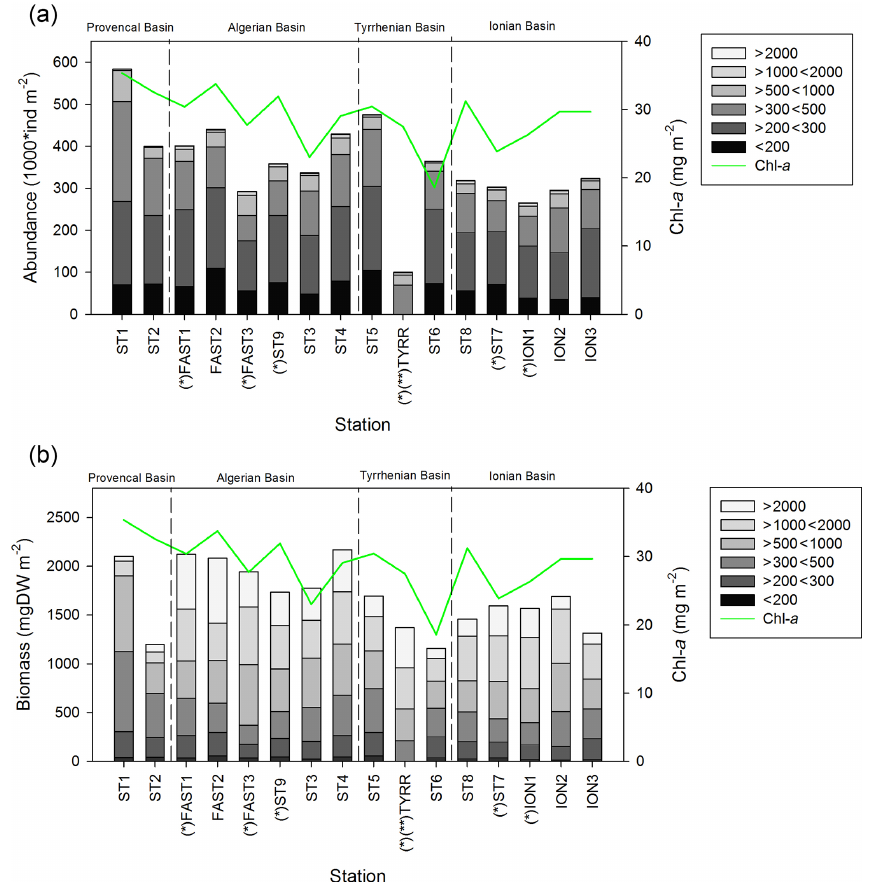
Figure 4. Values of zooplankton abundance (a) and biomass (b) cumulated by ESD size classes across different stations of the PEACETIME cruise. The green line shows the integrated Chl- a concentrations, “ ∗ ” denotes stations sampled during the night, and “ ∗∗ ” denotes that only the abundance and biomass values above 300µm are presented for TYR.